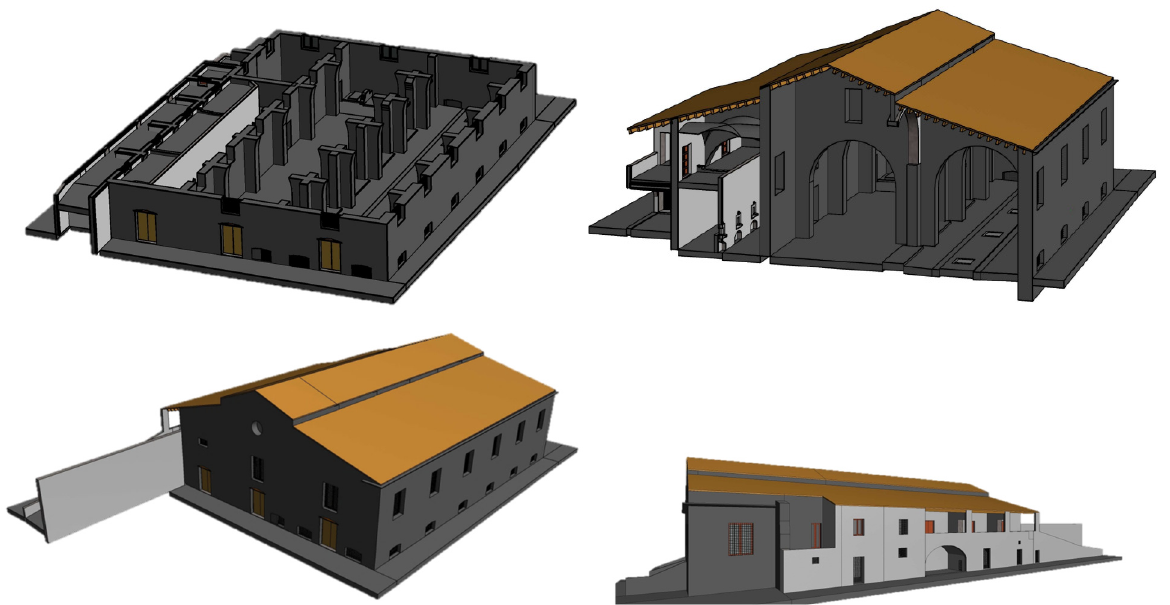
Figure 14. HBIM of the “Real Cantina Borbonica”: 3D views of the parametric